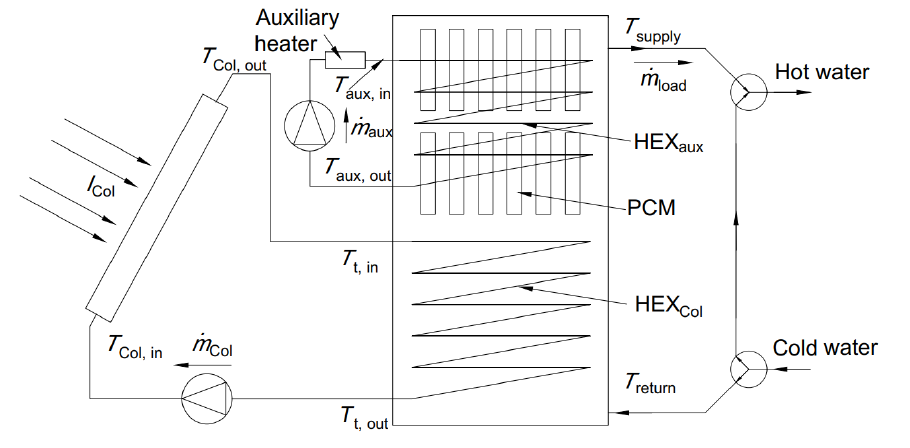
Fig. 2. Solar heating system used for sensitivity analysis with external auxiliary